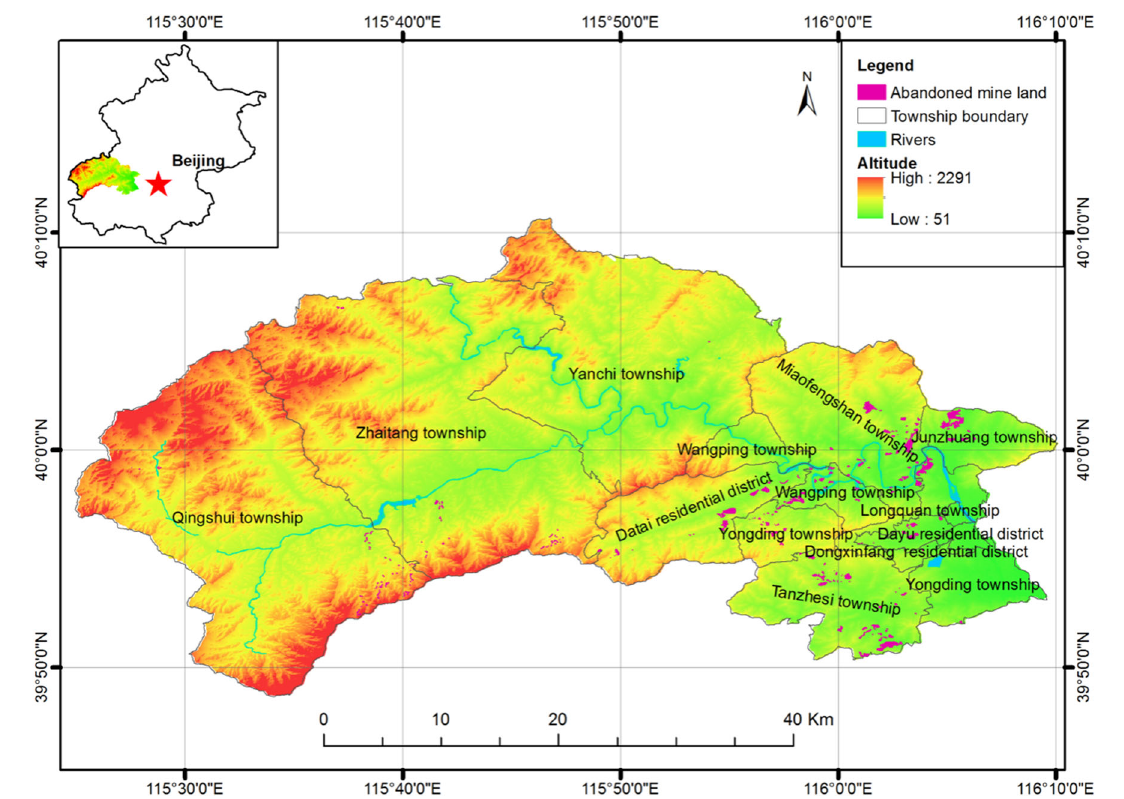
Fig. 1 Geographical position and distribution of abandoned mine land of Mentougou